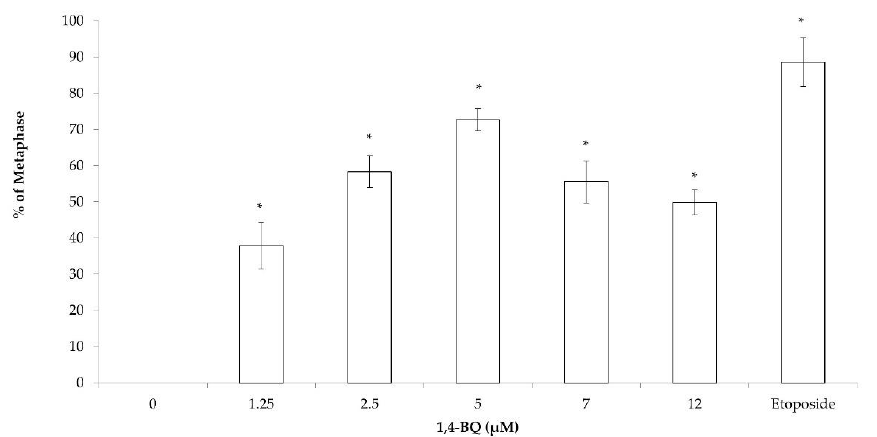
Figure 3. CA of MBMCs to 1,4-BQ treatment for 24 h. Twenty metaphases were scored for each experimental group and the percentage of CA is as presented. Data are presented as the mean ± SEM ( n = 3) and analyzed by using one-way ANOVA. * p < 0.05 compared with the negative con- trol group.